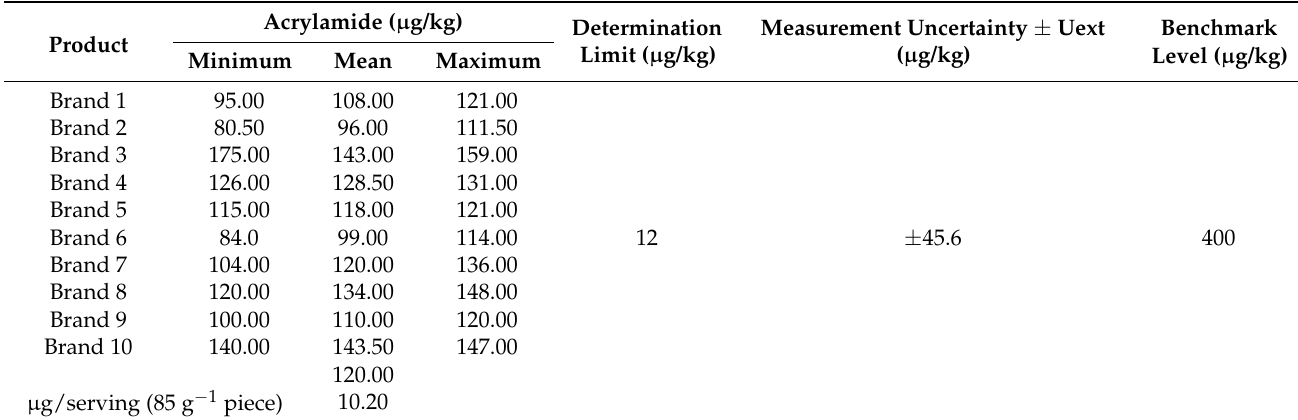
Table 4. The acrylamide level in pretzels ( µ g/kg).